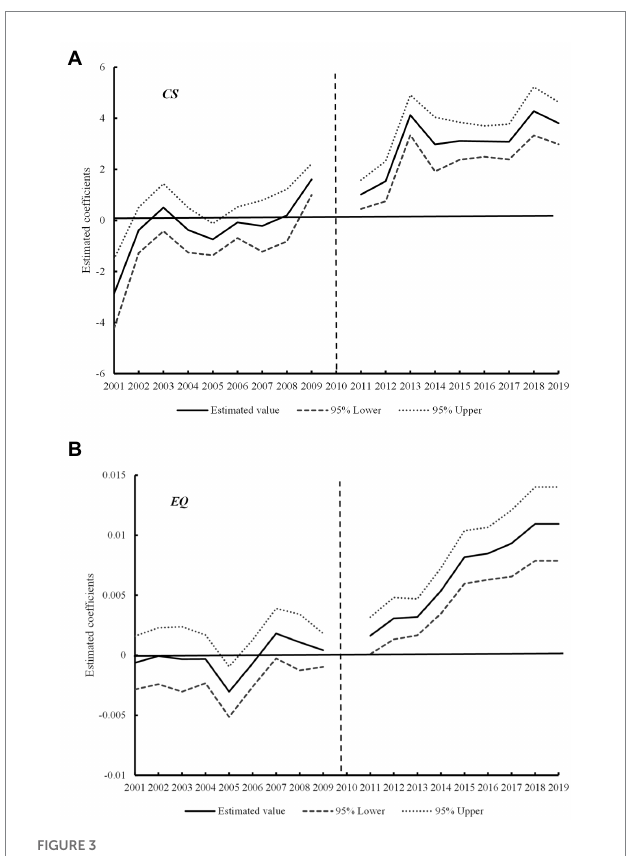
FIGURE 3 Parallel trend hypothesis and dynamic effects of NKEFAs on CS (A) and EQ (B) .